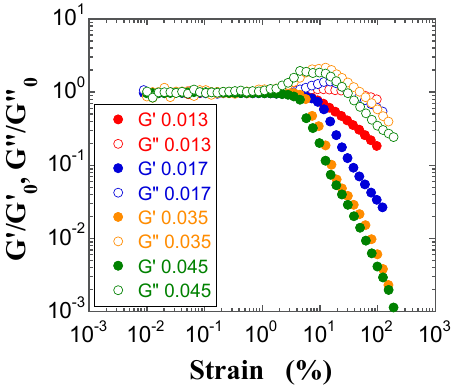
Figure 11. Double-logarithmic plots of G (cid:48) /G (cid:48) 0 (filled circles) and G” / G” 0 (open circles) for the FS suspensions at ϕ = 0.013 (red), 0.017 (red), 0.035 (orange), and 0.045 (green) as a function of strain. G” 0 is the loss modulus in the linear region.